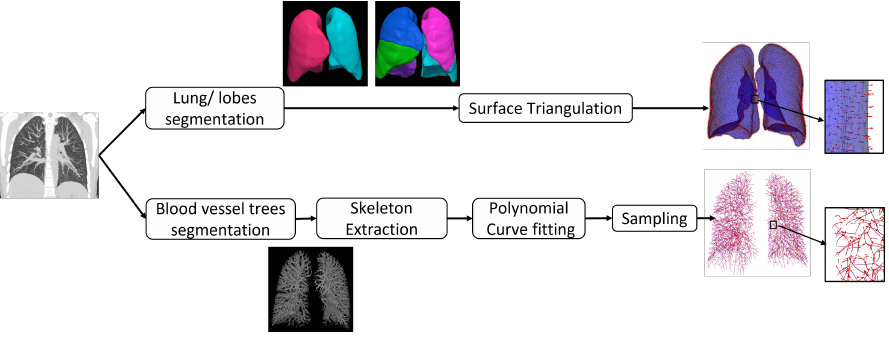
Figure 1. Preprocessing